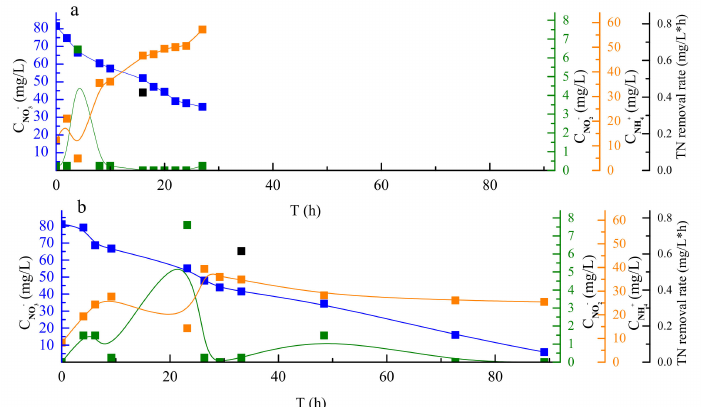
Figure 5. Changes in the concentration of NO 3 − -N, NH 4 + -N, and NO 2 − -N in MFC catholyte water samples over time and the average removal rate of TN (( a ) and ( b ) represent MFC-As and MFC- control,